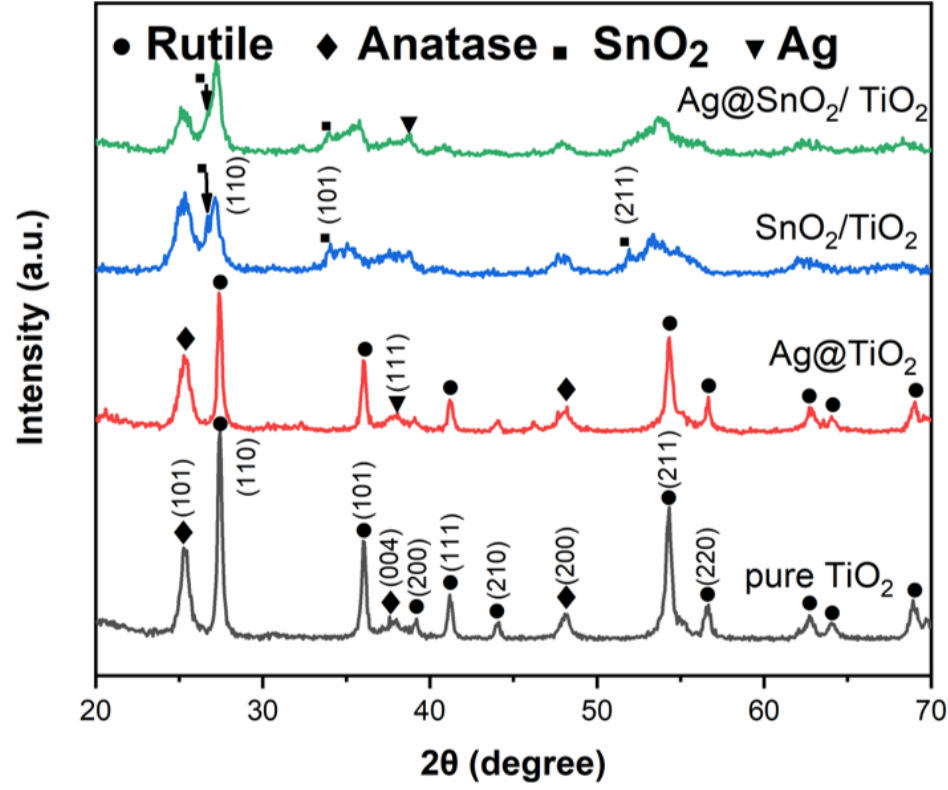
Figure 1. XRD patterns of pure TiO 2 , Ag@TiO 2 , SnO 2 /TiO 2 and Ag@SnO 2 /TiO 2 .